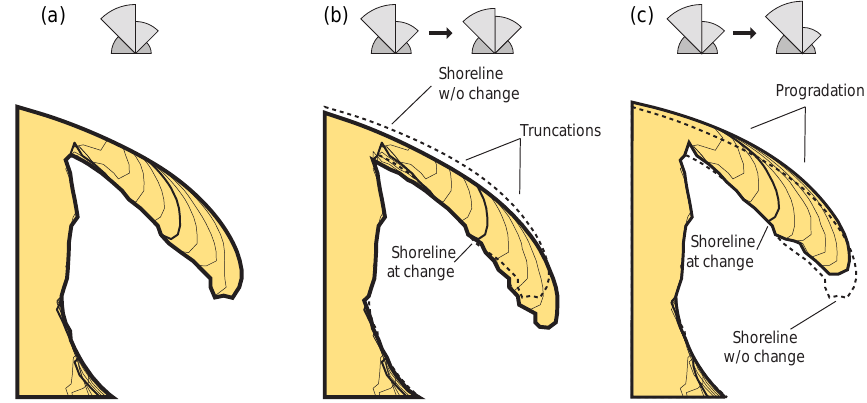
Figure 15. Model simulation of spit undergoing a 10% change in wave direction and directional spread climate during growth. (a) No change in wave climate ( A = 0 . 7 U = 0 . 2), (b) wave direction shifts to the right ( A = 0 . 6 U = 0 . 1), and (c) wave direction shifts to the left ( A = 0 . 8 U = 0 .